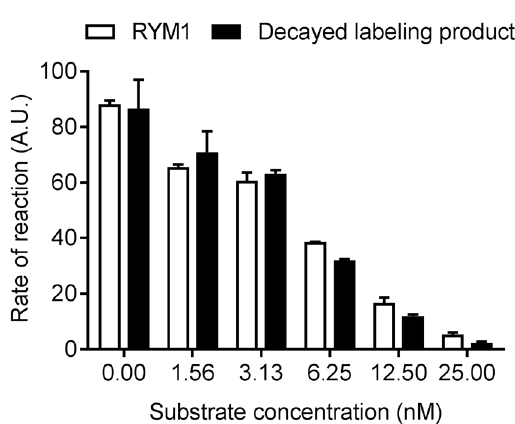
− 99m Tc-RYM1 and RP805; ( b ) stability of 99m Tc-RYM1 in saline; ( c ) stability of RP805 in saline; ( d ) 4 , stability of 99m Tc-RYM1 in blood; ( e ) stability of RP805 in blood; ( f ) stability of 99m Tc-RYM1(tricine) 2 in saline. A.U.: arbitrary units.